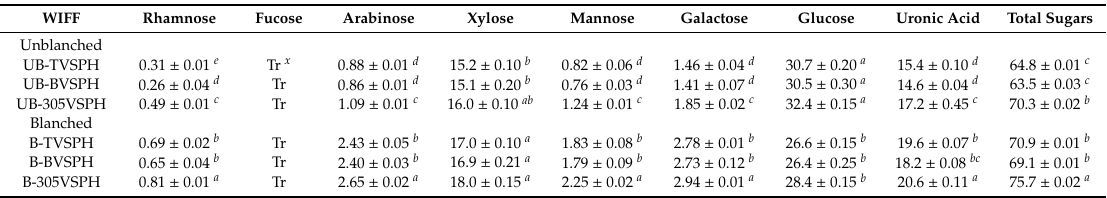
Table 3. Monosaccharide composition w of WIFF prepared from the unblanched and blanched vegetable soybean pod